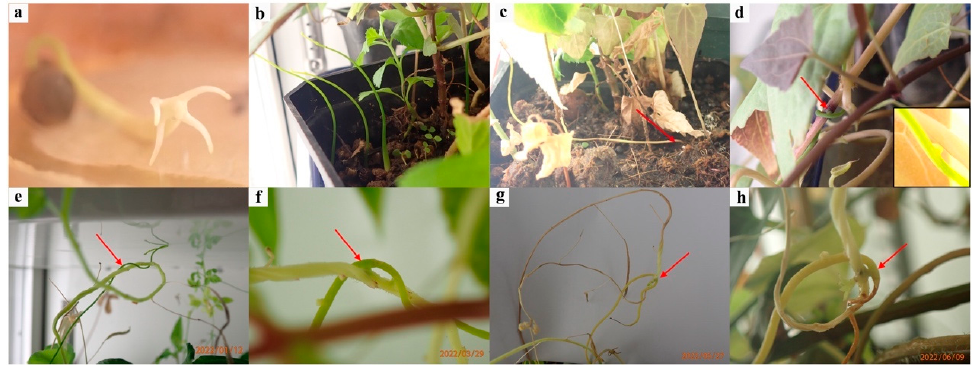
Figure 3. Images of Cassytha filiformis growth and parasitic processes on host species in laboratory conditions. ( a ) Germinated seed with a rudimentary and short-lived root. ( b ) Independent growth stage of seedlings. ( c ) The dead C. filiformis seedlings unsuccessfully parasitized a viable host; the red arrow indicates the dead stem of C. filiformis. ( d ) The survived Cassytha filiformis seedlings successfully parasitized the viable host Mikania micrantha with the haustoria. ( e – h ) Cassytha filiformis – Cleome rutidosperma host associations via the haustoria. The thin stem is C. filiformis , and the thick stem is C. rutidosperma. The red arrows indicate infected parts .